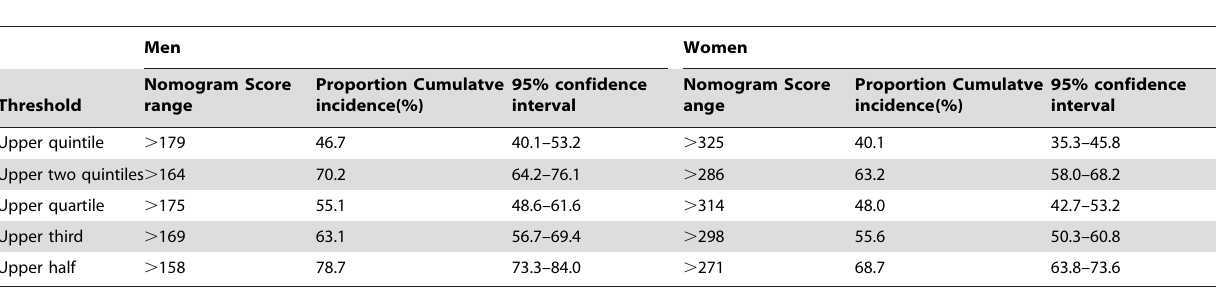
Table 5. Proportion of Cumulative Incidence Contributed by Different Definitions of Most-at-risk status.